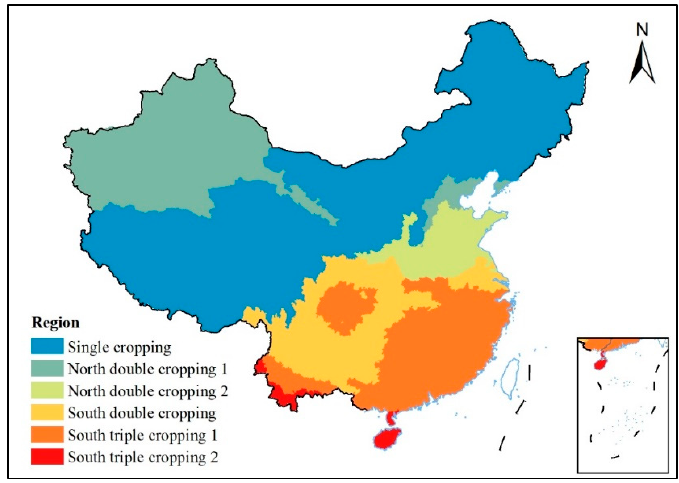
Figure 1. Distribution of the six agricultural regions with different cropping patterns in China.